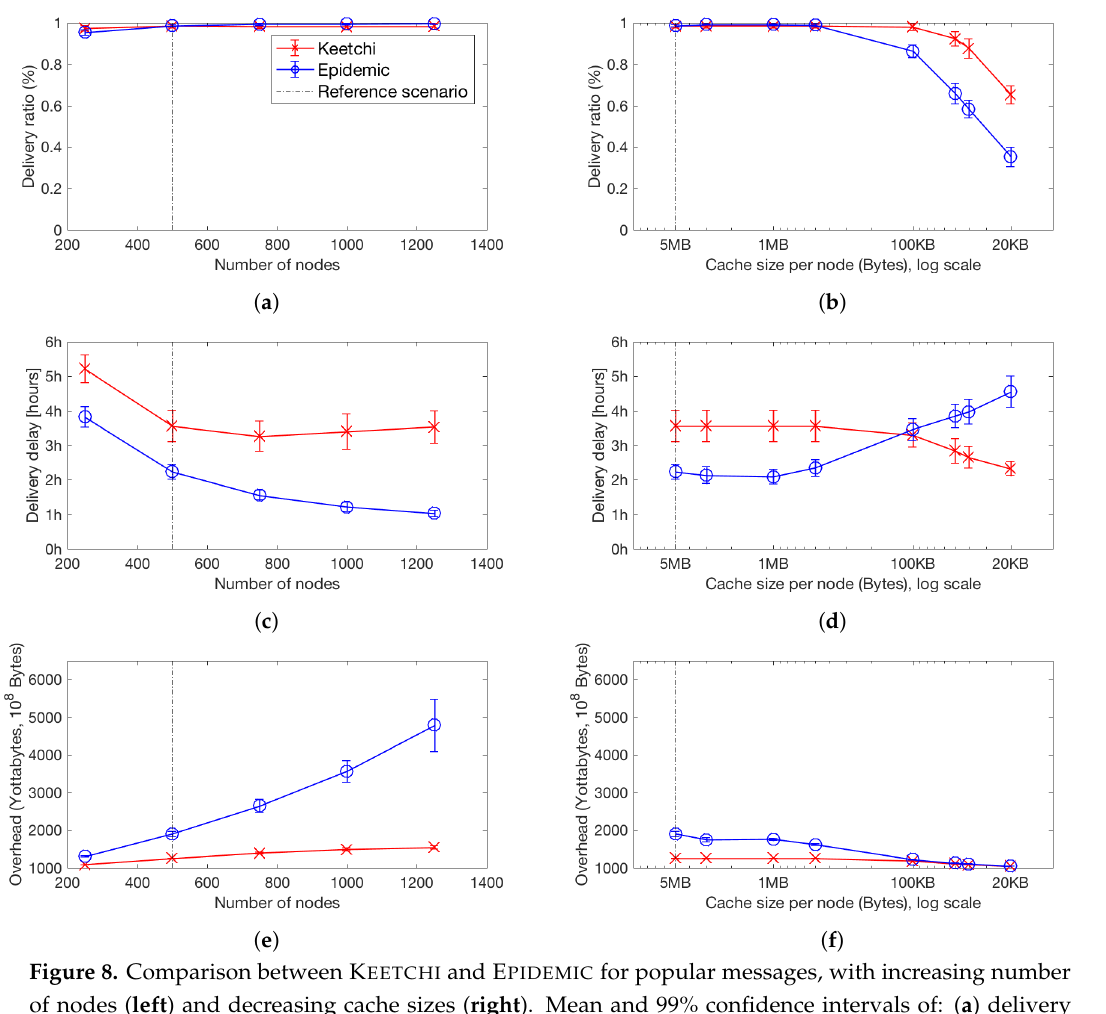
Figure 8. Comparison between K EETCHI and E PIDEMIC for popular messages, with increasing number of nodes ( left ) and decreasing cache sizes ( right ). Mean and 99% confidence intervals of: ( a ) delivery ratio, popular messages with more network nodes; ( b ) delivery ratio, popular messages with decreasing cache size; ( c ) delivery delay, popular messages with more network nodes; ( d ) delivery delay for popular messages with decreasing cache size; ( e ) network overhead, popular messages with more network nodes; and ( f ) network overhead, popular messages with decreasing cache